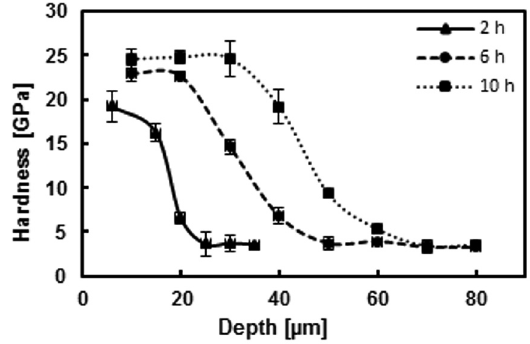
Figure 5. Hardness profile along the boride layer formed on AISI 304 steel at 1223 K. Indentation load of 50 mN with a Berkovich